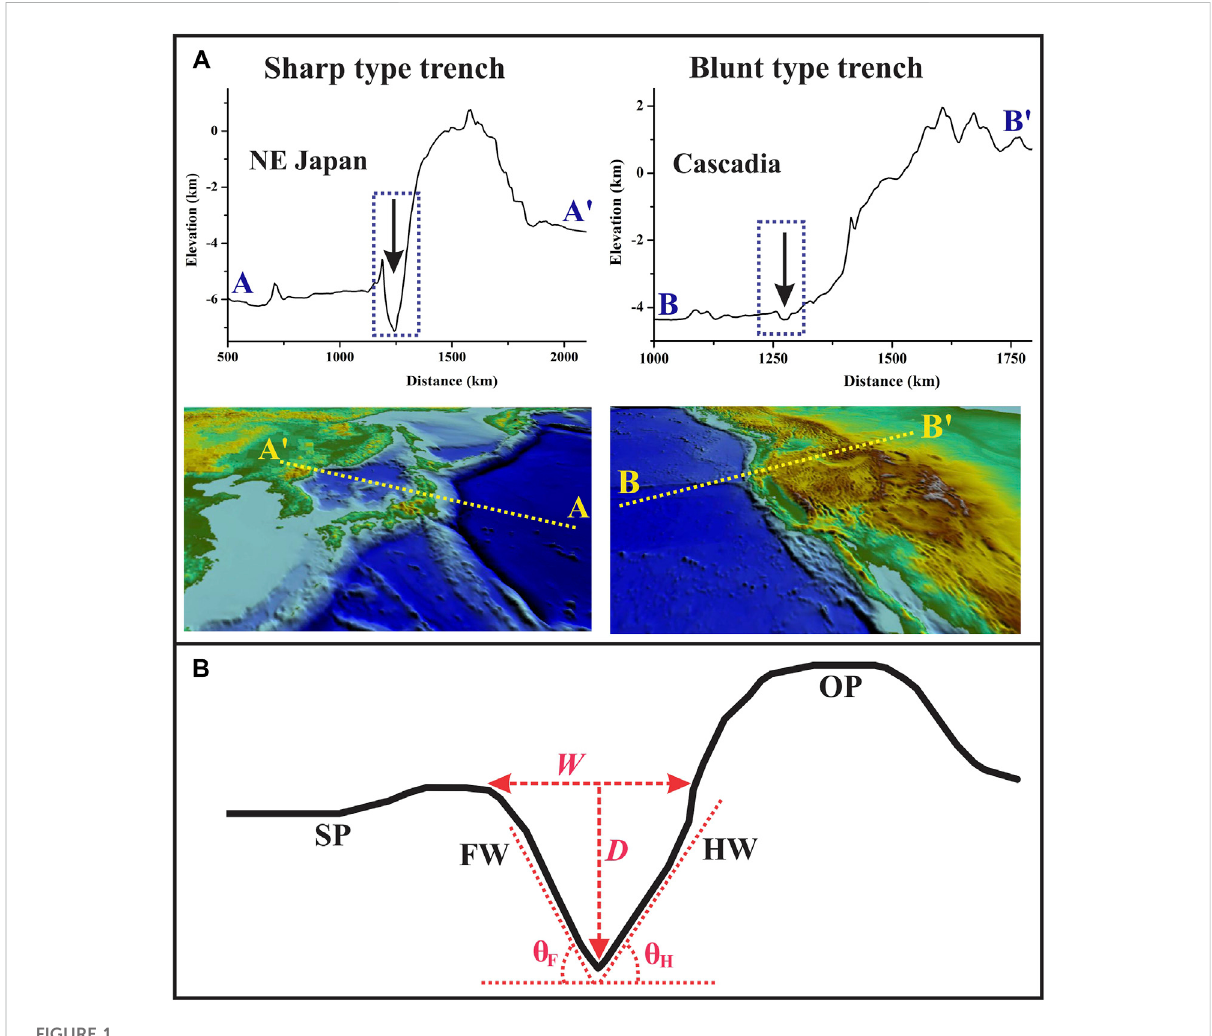
FIGURE 1 (A) Two extreme trench geometries: sharp and blunt from the North East Japan and the Cascadia subduction zones, respectively. (B) Geometrical parameters considered for the analysis of trench topography: trench opening width ( W ) and maximum negative relative relief (D). θ F : fore-wall (FW) slopes on the subducting plate (SP); θ H : hinter-wall (HW) slopes on the overriding plate